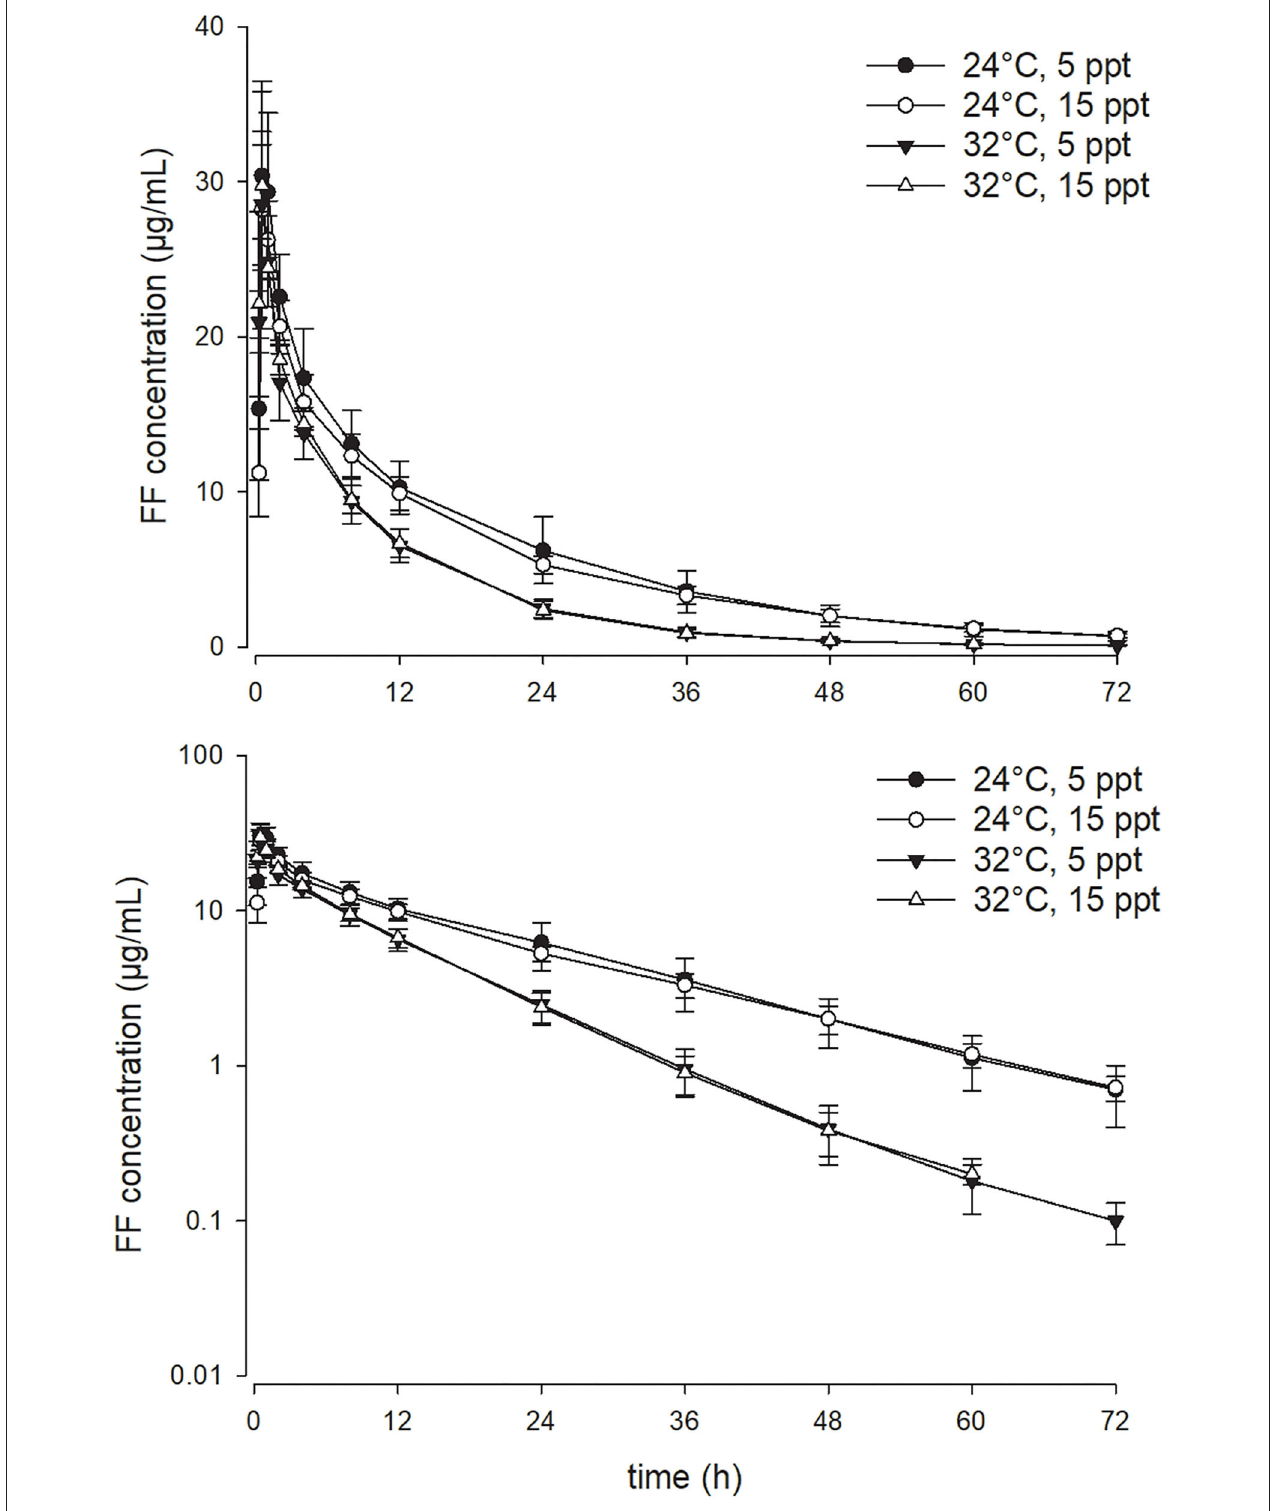
FIGURE 2 | Linear (above) and semi-logarithmic plots (below) of the complete serum concentration-time profile from 0 to 72h (mean ± SD) of 15 mg/kg florfenicol following oral (PO) administration at two temperatures and two salinities ( n = 4 for the 32 ◦ C with 15 ppt group; n = 7 for the other three groups).